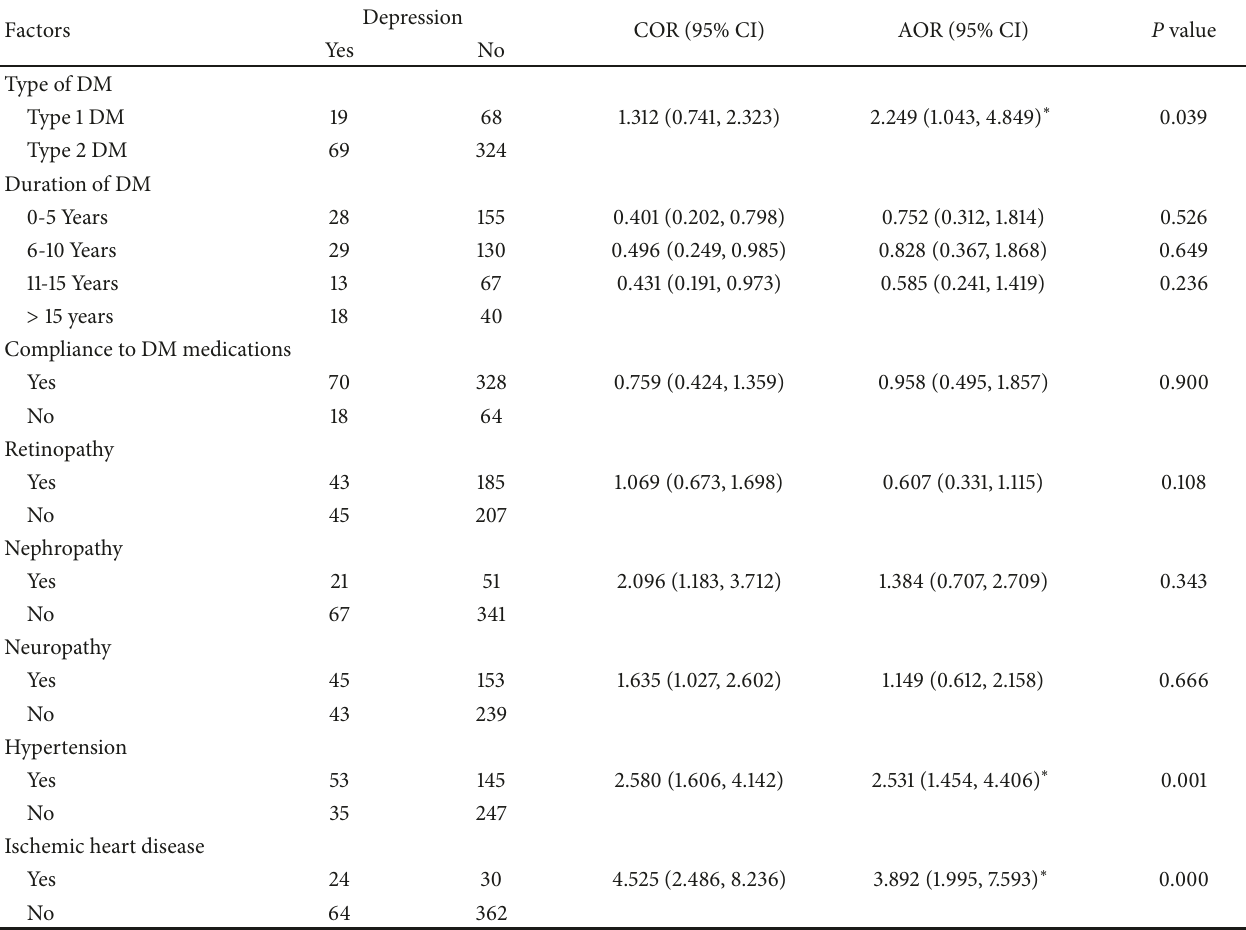
Table 4: Multivariate analysis of different factors and depression among diabetic patients, Jazan, May 2017 (N = 480).